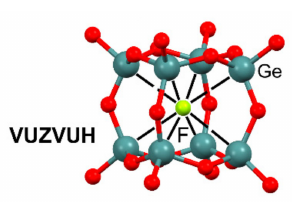
Figure 4. Ball-and-stick representation of the solid state of VUZVUH structure [73] highlighting the O–Ge ··· F TtBs, which are represented using dashed lines. H atoms omitted for